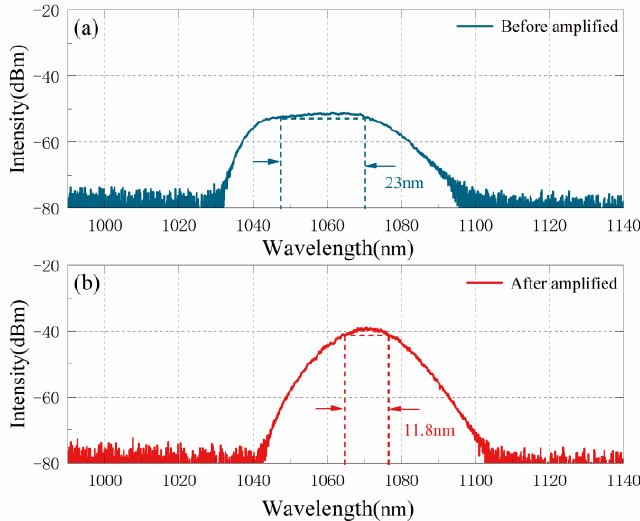
Figure 2. The spectrum of ASE seed source and spectrum after power amplification. According to the conservation formula of energy and momentum satisfied by the three wavelengths simultaneously, the appropriate crystal polarization period for the optical parametric oscillation of the 1018 nm laser and the DFG with the 1073 nm pump beam is simulated. It can be expressed in the form of the following equations: